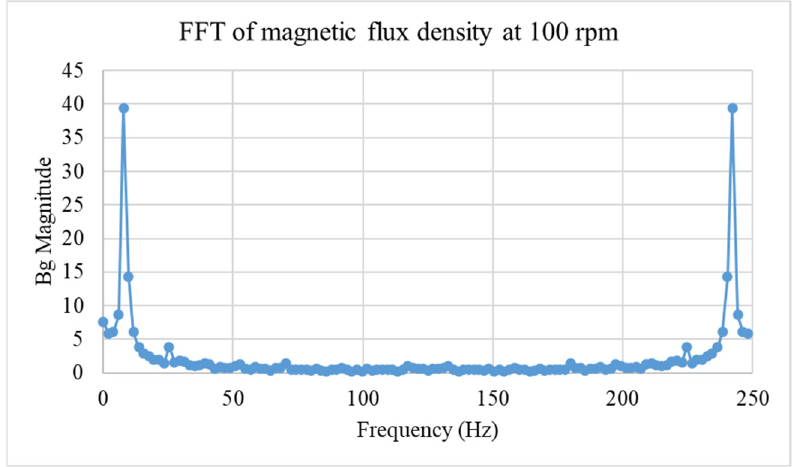
Figure 12. FFT of magnetic flux density trend at 100 rpm.